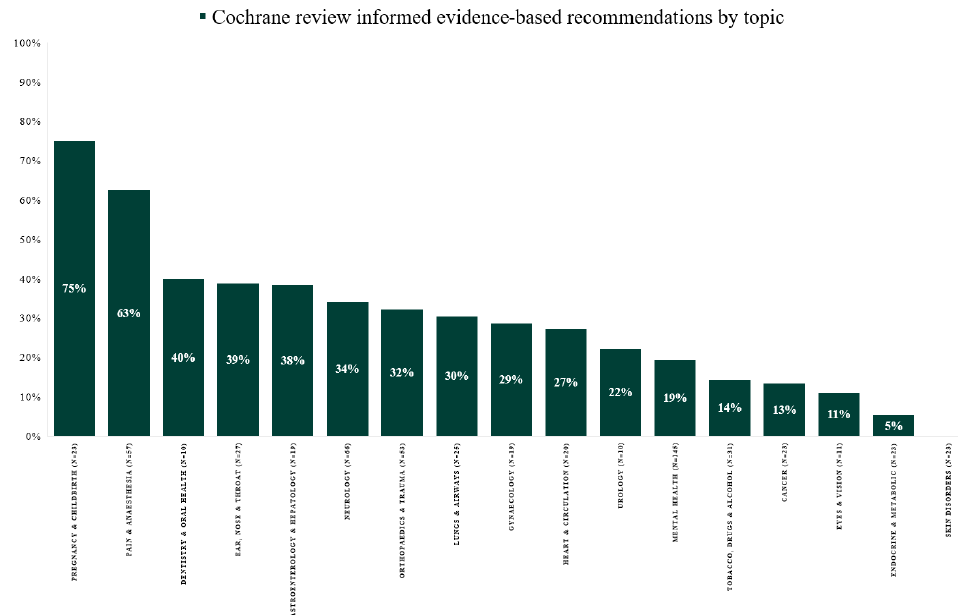
Figure 2. Evidence-based recommendations informed by evidence from Cochrane reviews by topic in Danish National Clinical Guideline development from 2014 to 2021.